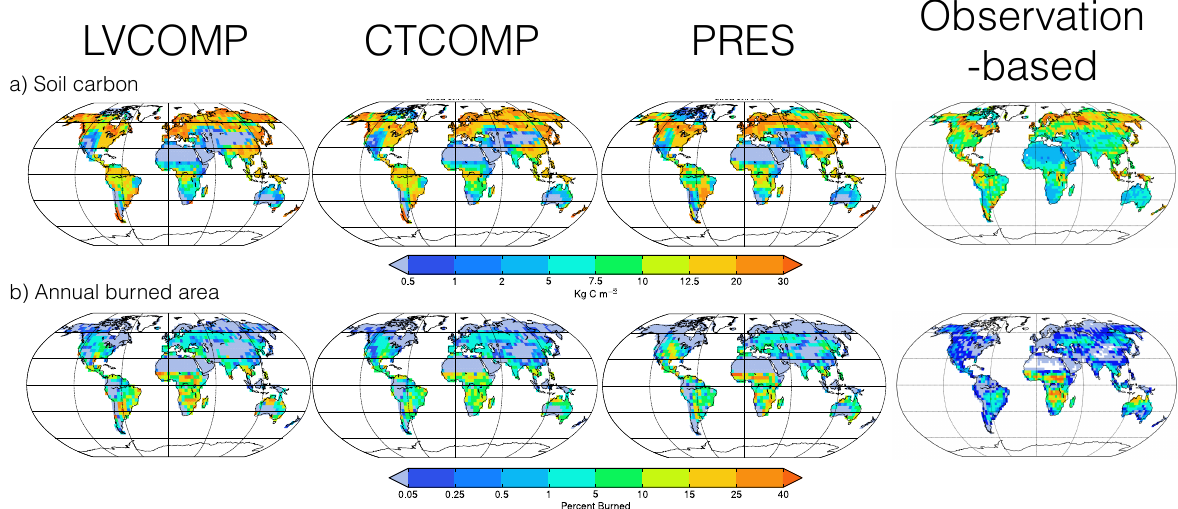
Figure 8. Geographical distribution of modelled soil carbon mass (a) , and percentage of annual burned area (b) based on simulations that use dynamically modelled fractional coverage of PFTs based on the original L–V equations (LVCOMP, first column) and the modified L–V equations (CTCOMP, second column). The third column shows the results for the simulation that uses prescribed PFT fractional cover based on the modified Wang et al. (2006) data set simulation (PRES). The fourth column has observation-based data sets for soil carbon mass (HWSD v. 1.2; FAO/IIASA/ISRIC/ISS-CAS/JRC, 2012) and burned area (GFED v. 3.1; Giglio et al.,